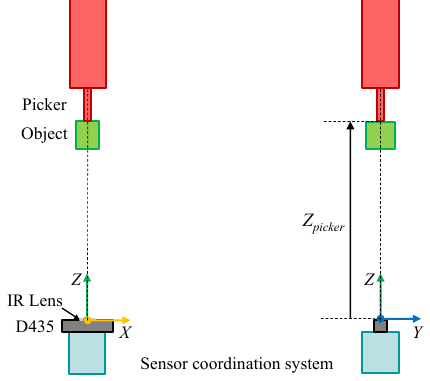
Figure 2. The configuration of the picker and the RGB-D